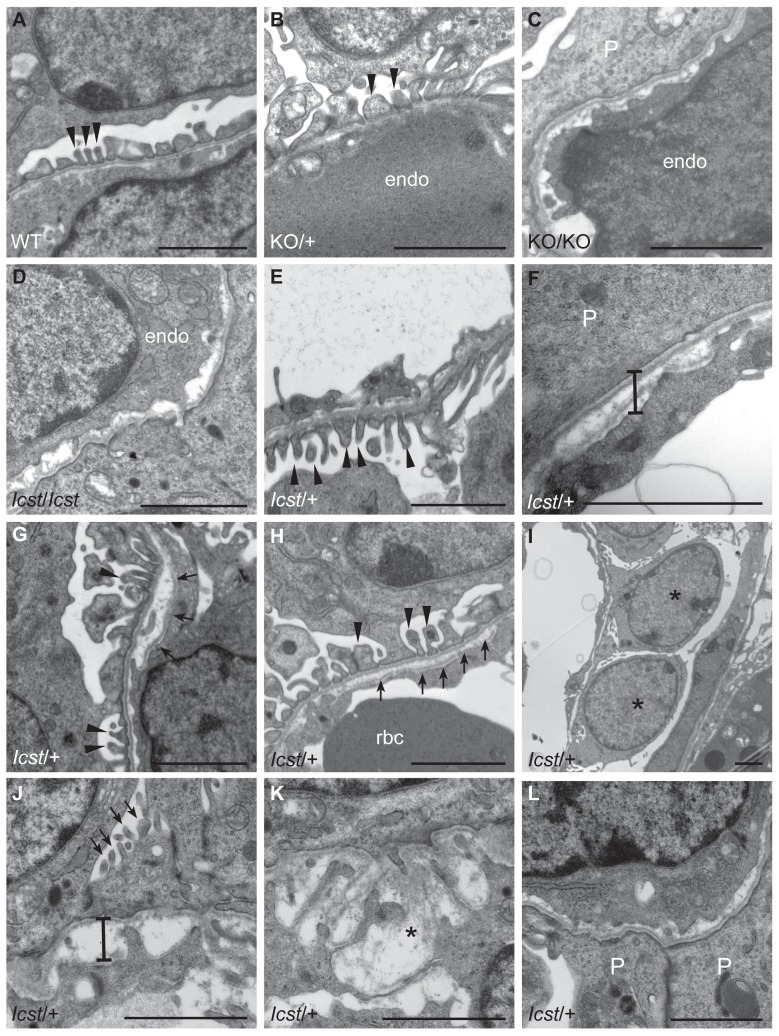
Ultrastructural analysis of E17.5 and E18.5 kidneys shows that Icst causes glomerular defects when heterozygous.(A–B) Wild-type (WT) and Lmx1bKO/+ (KO/+) podocytes are normal with normal foot process formation (arrowheads). (C–D) Lmx1bKO/KO (KO/KO) and Lmx1bIcst/Icst (Icst/Icst) podocytes fail to form foot processes and appear immature. (E–L) Lmx1bIcst heterozygous podocytes (Icst/+). (E) Normal foot process formation (arrowheads). (F) The bar indicates an area of the GBM that appears fragmented. (G–H) Foot processes (arrowheads) abut GBM that is split (arrows). (I) The podocytes appear cuboidal (as indicated by asterisks) and immature. (J) The GBM is split as indicated by the bar and foot processes are rudimentary (arrows). (K) There is a large split in the GBM that is filled with fibrillar material (as indicated by an asterisk). (L) Podocytes are positioned flush against a split GBM. P, podocyte; endo = endothelial cell. Scale bar = 2 µm.